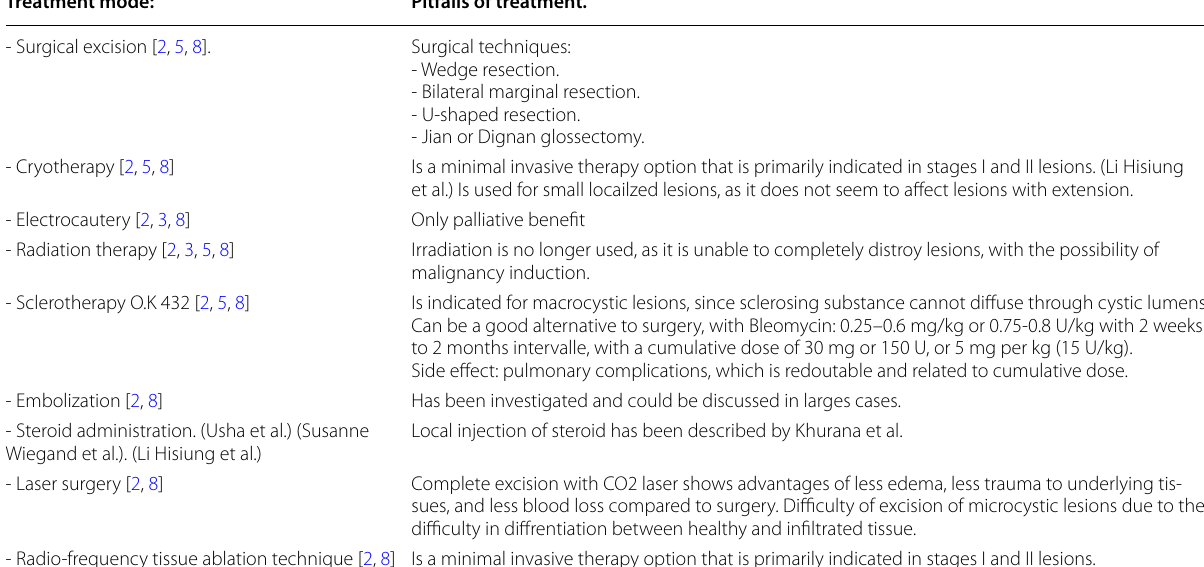
Table 2 Treatment possibilities for cystic lymphangiomas of the tongue [2, 5, 6, 8] Treatment mode: Pitfalls of